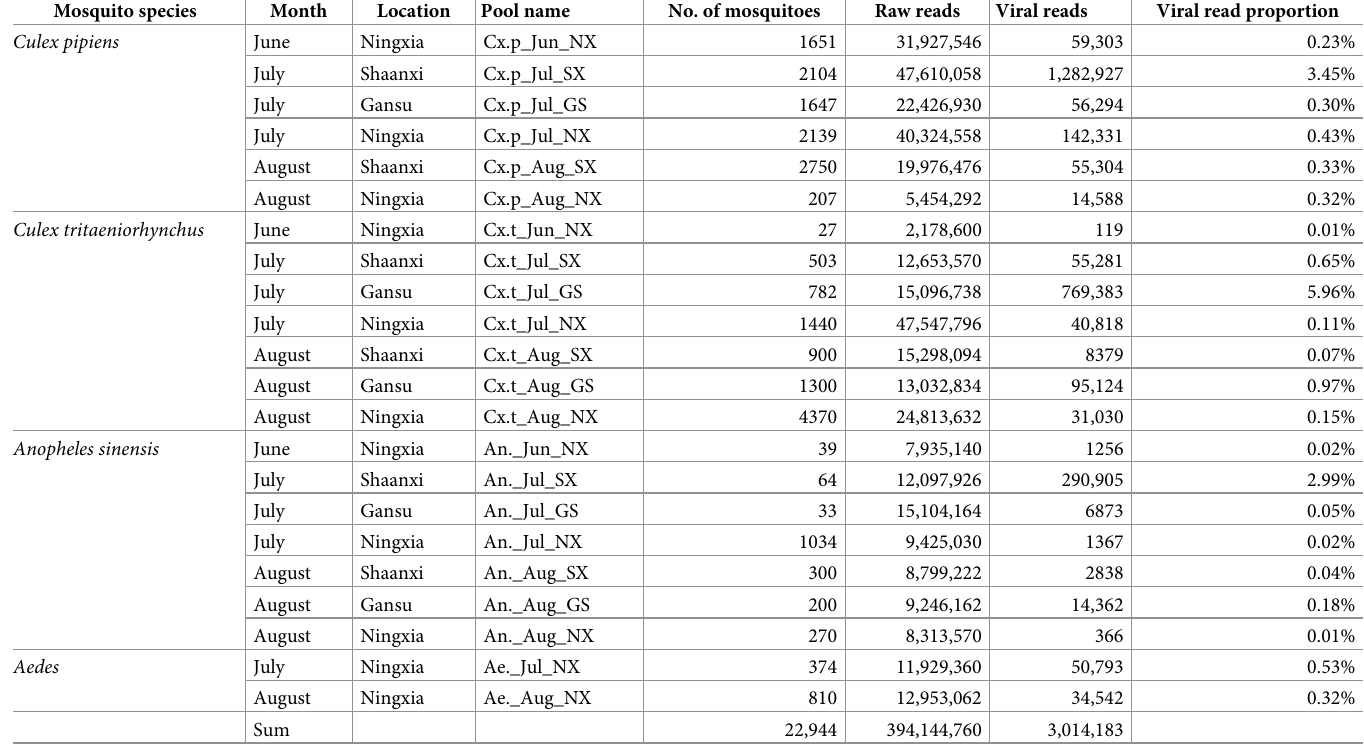
Table 1. Mosquito collection and sequencing data